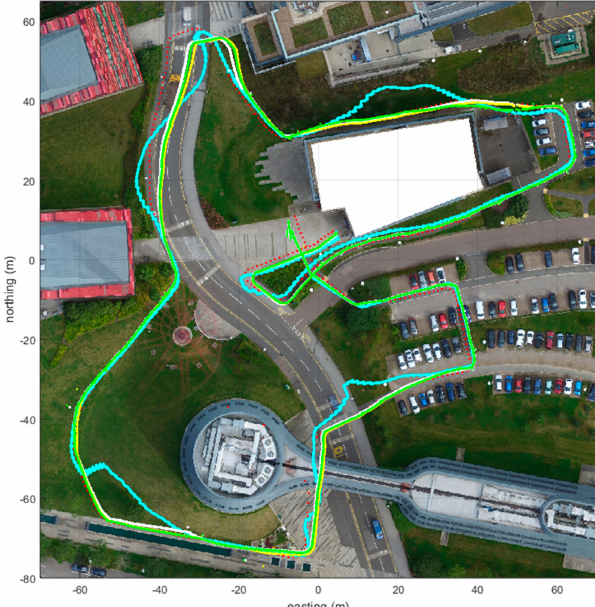
Figure 10. When the anomaly detection method is not used and the GNSS measurements are treated as being of equal quality, the resulting fusion of the PDR and the GNSS with the anomalous trails produce the cyan track, which follows the anomalies. Use of the GNSS anomaly detection method the GNSS measurements can be fused so that the GNSS measurements with anomalies are weighted much less, and the trail resembles the true trajectory (white, green and yellow tracks resemble the red track form, which is the ground